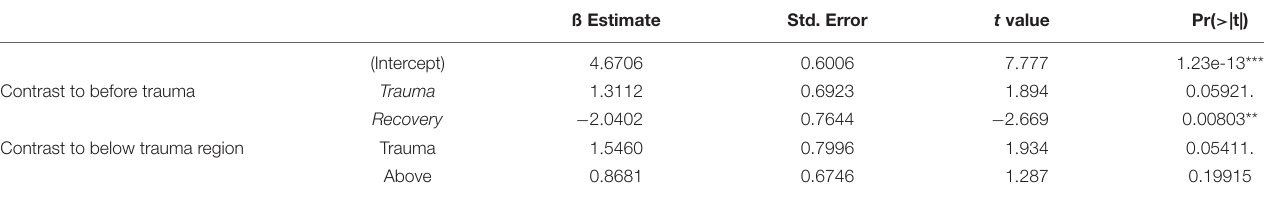
TABLE 1 | Linear regression of slope.